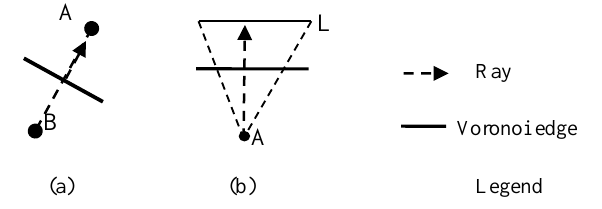
Fig.7 Normals of the Voronoi edges used to denote directions. Fig. 7. Normals of the Voronoi edges used to denote directions.